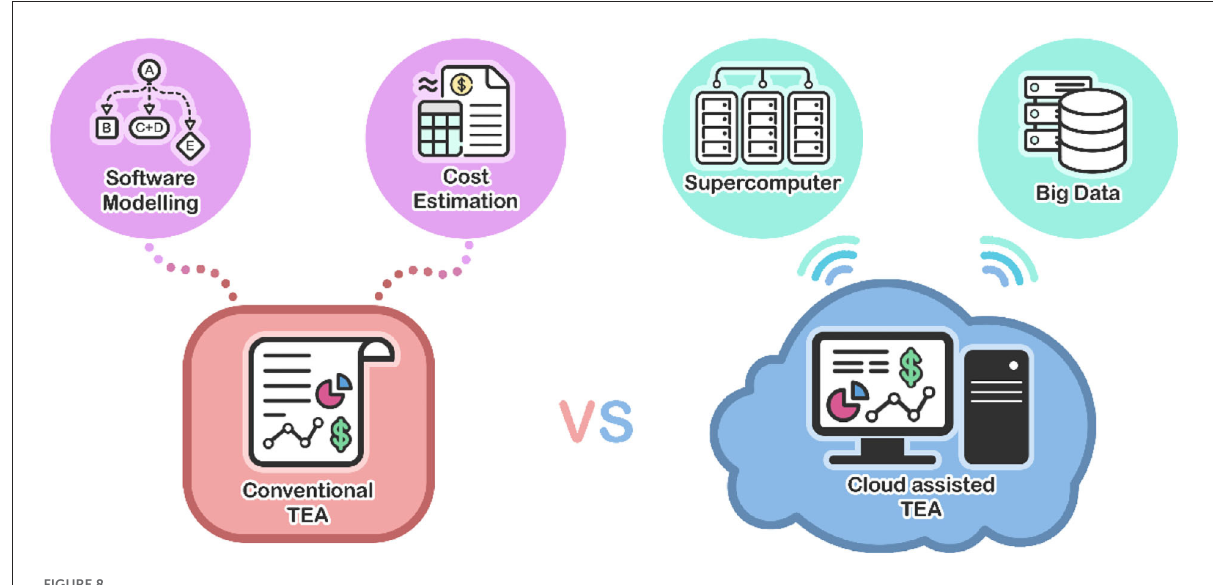
FIGURE8 Conventional vs. Cloud assisted